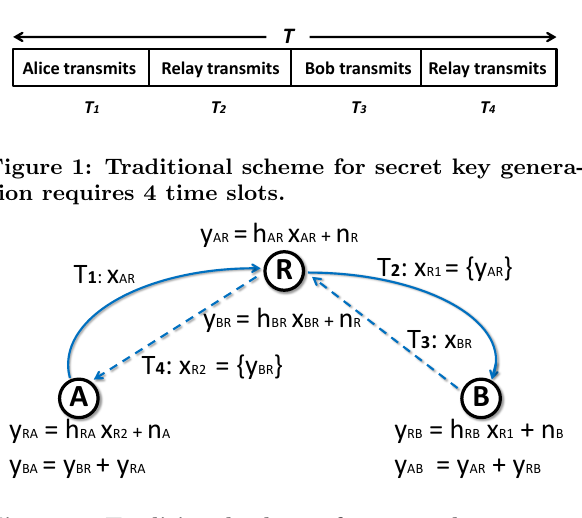
Figure 2: Traditional scheme for secret key genera- tion